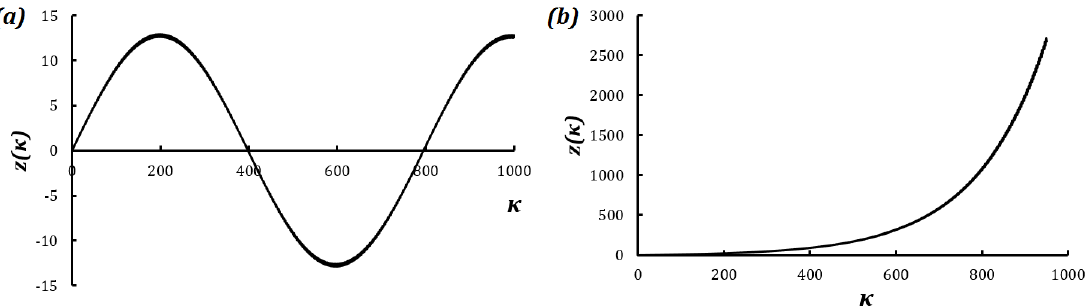
Figure 2. Solutions to the Mathieu equation for a tensile loaded beam with boundary conditions z = 0 at κ = 0 and dz/dκ = 0 at κ = 0. ( a ) Stable solution for δ = − 0.00025, ε = 0.05, and ( b ) unstable solution for δ = − 0.00035, ε = 0.05.